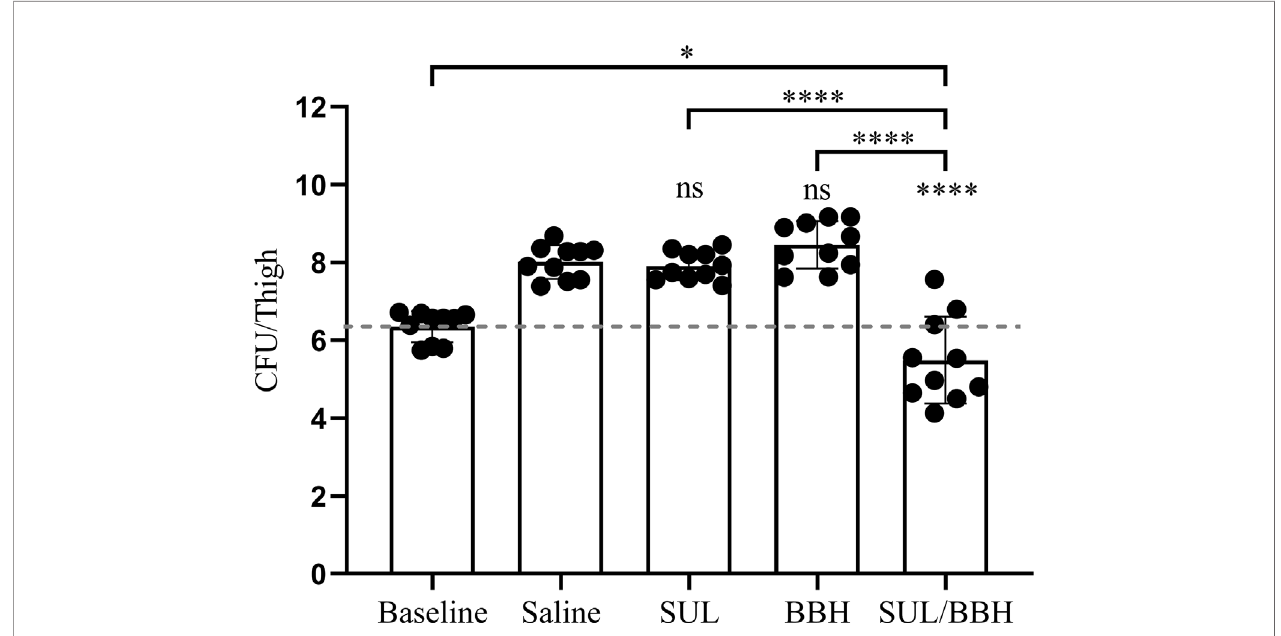
FIGURE 2 | Ef fi ciency of SUL/BBH combination therapy against MDR-TJ in murine thigh infection model (n = 5 mice, 10 thighs). The data were obtained from one single test and statistical analysis was carried out using one-way analysis of variance (ANOVA) with Tukey ’ s test by GraphPad Prism 8. ns, no signi fi cance; *P < 0.05; ****P <